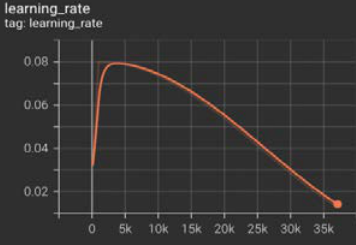
Fig. 4. Model training process.